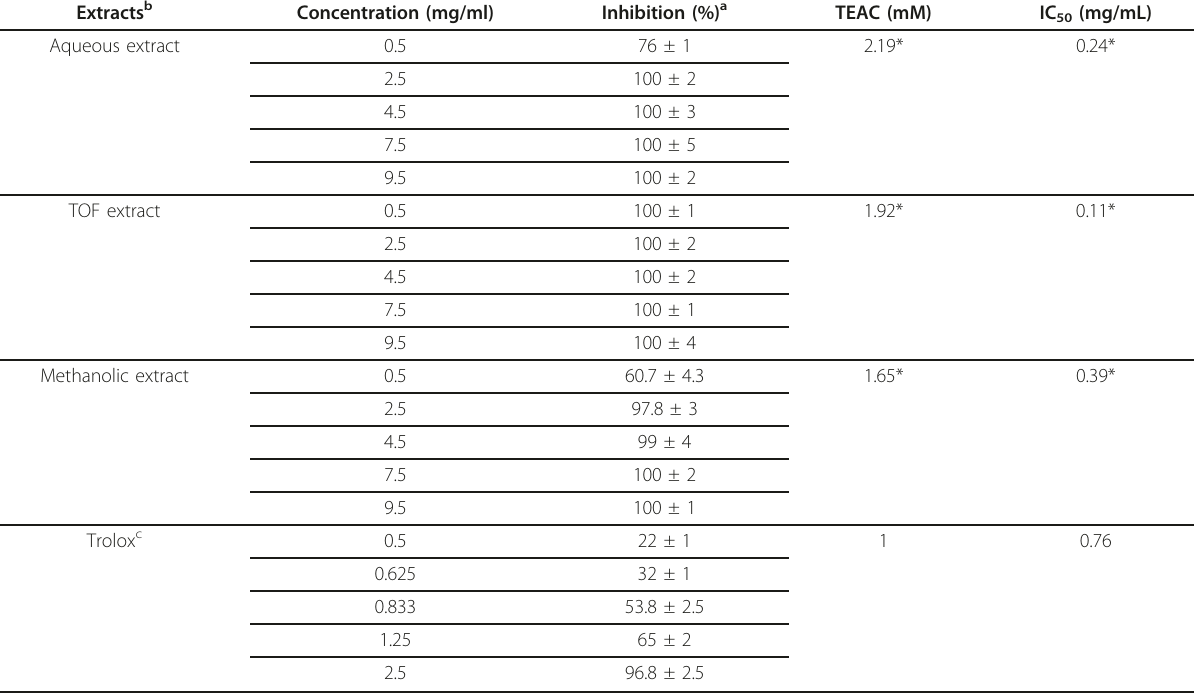
Table 2 Concentration-dependent ABTS free radical scavenging activity of A. salicina leaves extracts and standard antioxidant Trolox Extracts